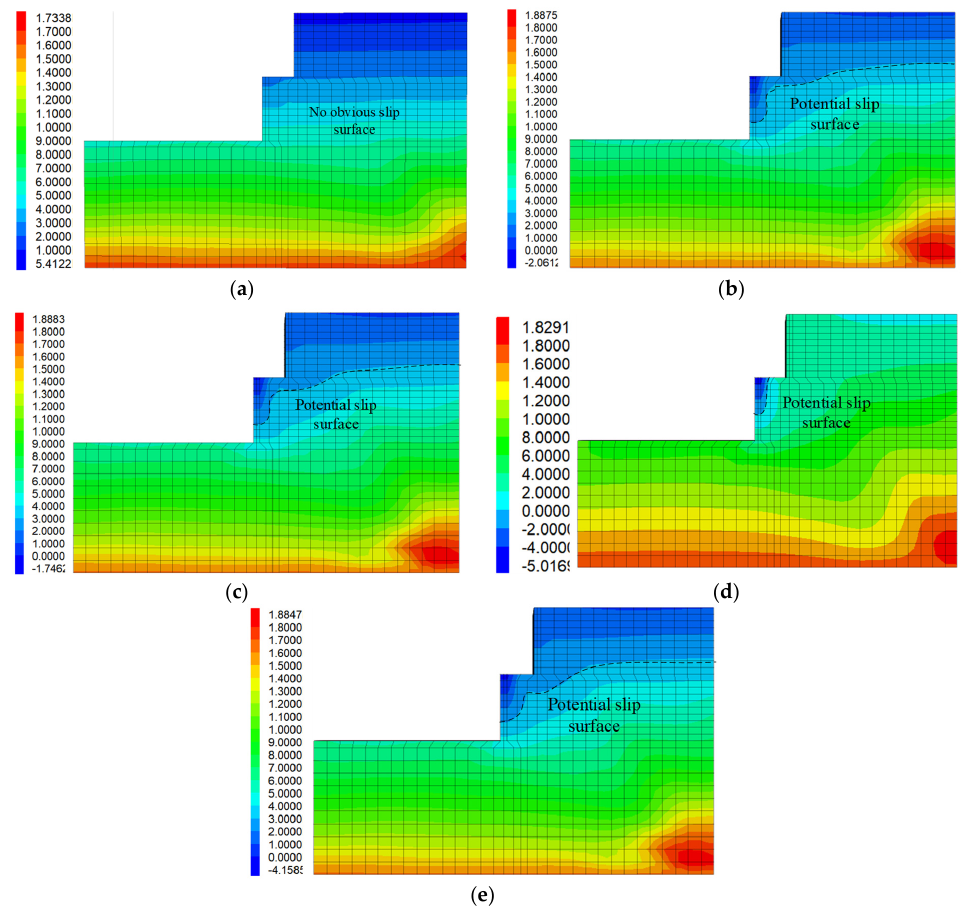
Figure 15. Horizontal displacement cloud map and slip surface distribution of retaining wall under different conditions (unit: cm): ( a ) ∆ H = 3; ( b ) ∆ H = 4; ( c ) ∆ H = 5; ( d ) ∆ H = 6; ( e ) ∆ H =